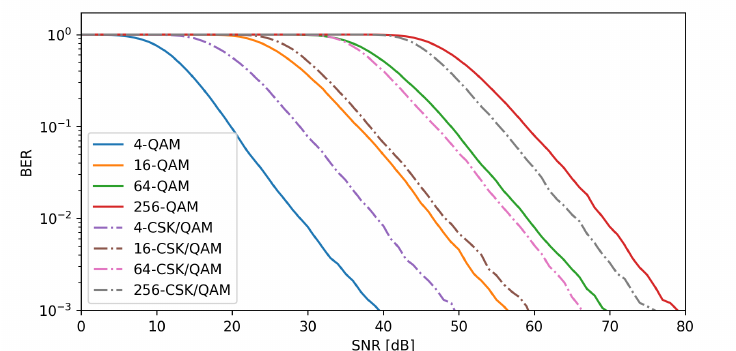
Figure 13. BER at different SNR levels in a N = 2 2 i × 2 2 i MIMO array for i = 0,1,2,3.